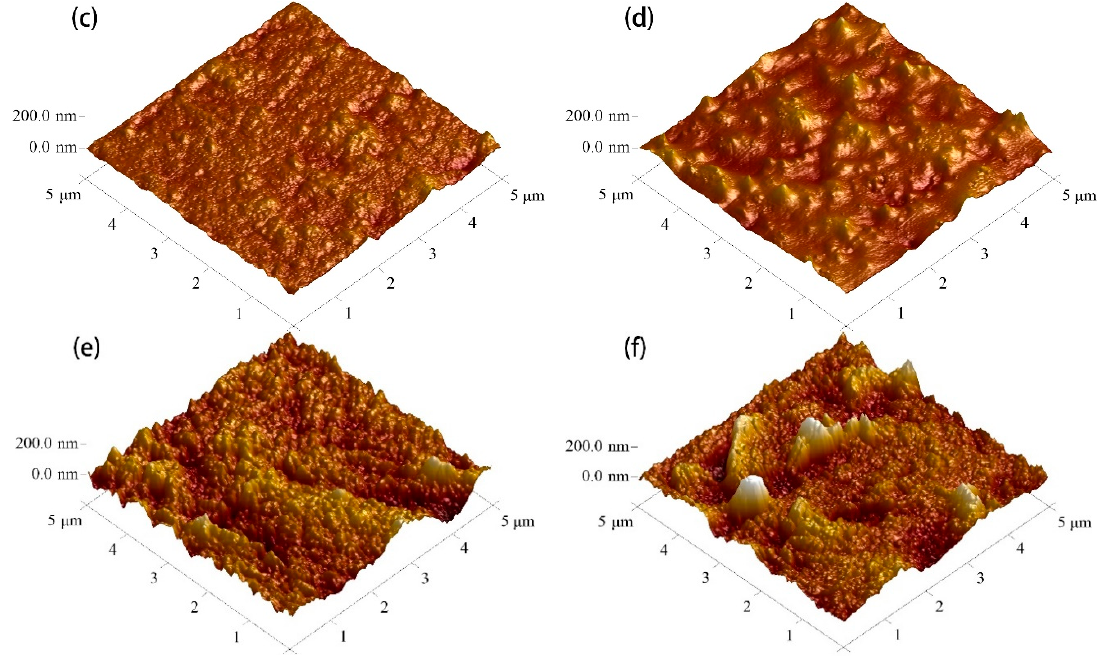
Figure 3. AFM images of: untreated POM fiber ( a ); and fiber subjected to DBD plasma treatment for: 30 s ( b ); 60 s ( c ); 90 s ( d ); 120 s ( e ); and 180 s ( f ).